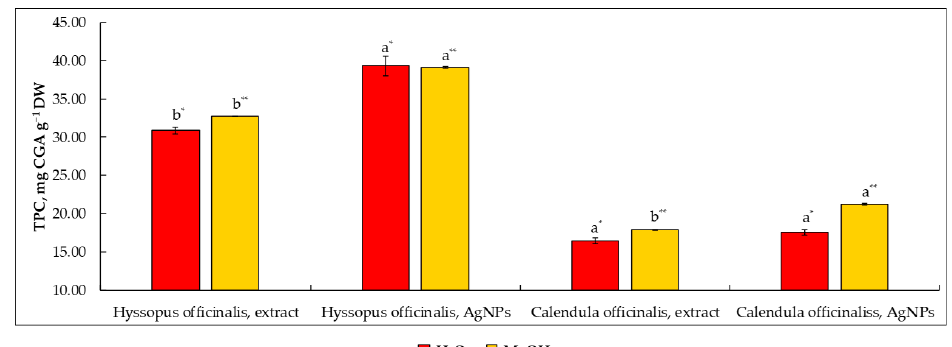
Figure 1. The number of total phenolics in Hyssopus and Calendula water extracts and their mediated silver nanoparticles according to the determination method (H 2 O and MeOH used as diluent). Note: Values are means ± SD of triplicates (n = 3). Means within the same plant material and diluent (H 2 O* or MeOH**) with different superscript letters ( a,b ) are significantly different (one-way ANOVA and Tukey’s test, p ≤ 0.05). SD—standard deviation; DW—on a dry weight